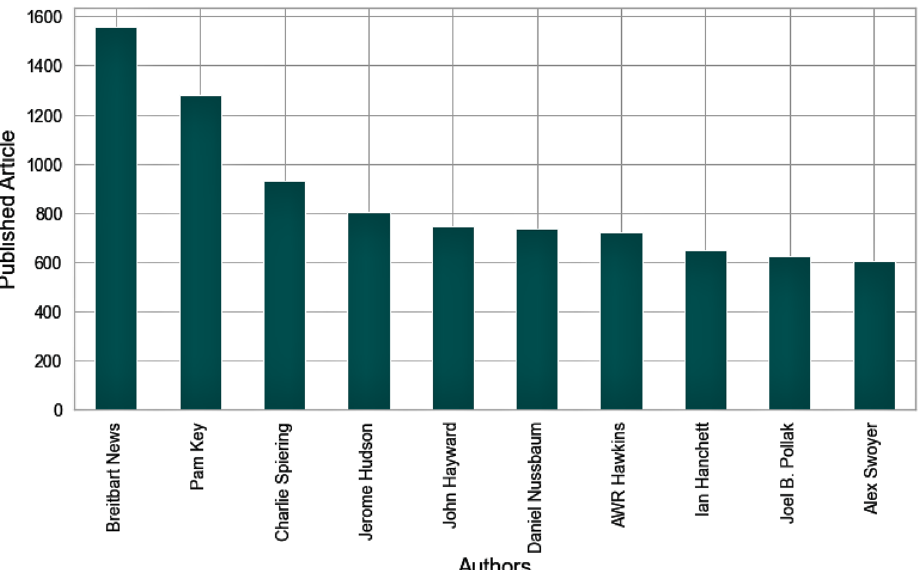
Figure 3. Top 10 authors in article1 dataset.